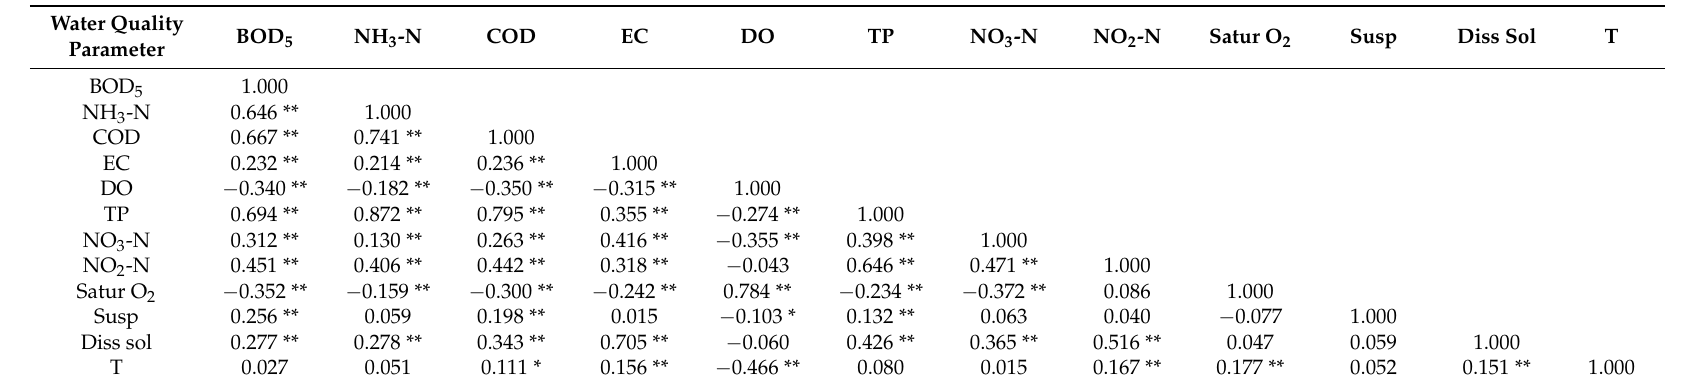
Table 2. Pearson correlation matrix for the water quality parameters across the sample